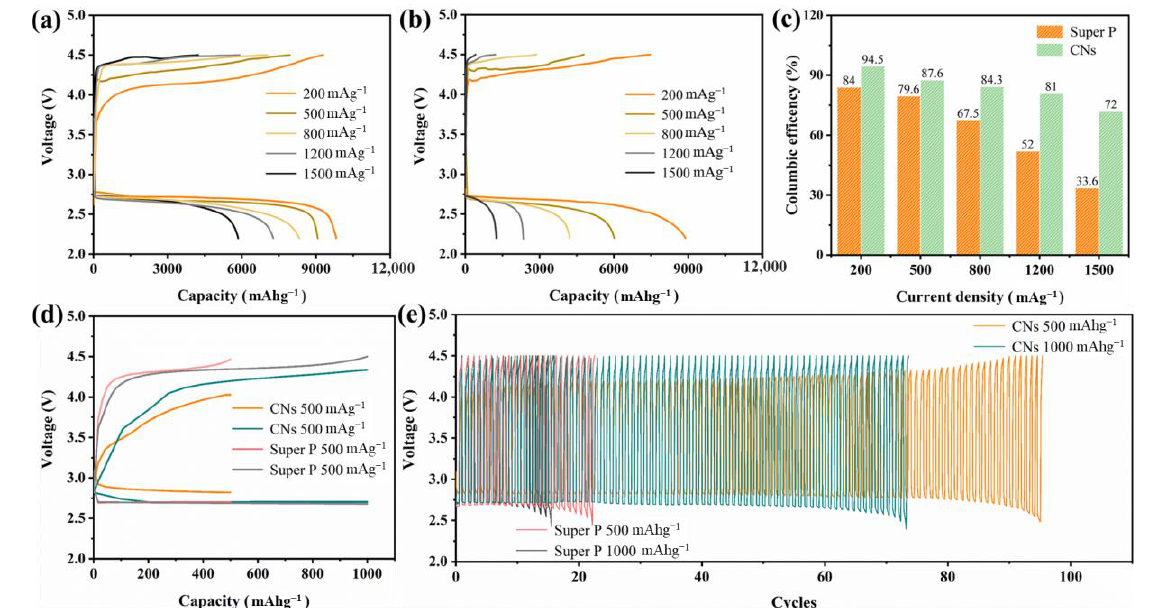
Figure 7. Ful discharge – charge curves of Li-CO 2 /O 2 battery with carbon nanosheets ( a ) and Super P ( b ) cathode at different current densities; the corresponding columbic efficiency has been provided for visible comparison ( c ); the first discharge-charge curve ( d ) and cycling performance ( e ) of Li-CO 2 /O 2 battery with carbon nanosheets and Super P cathodes at different restricted capacities and 500 mA g −1 .